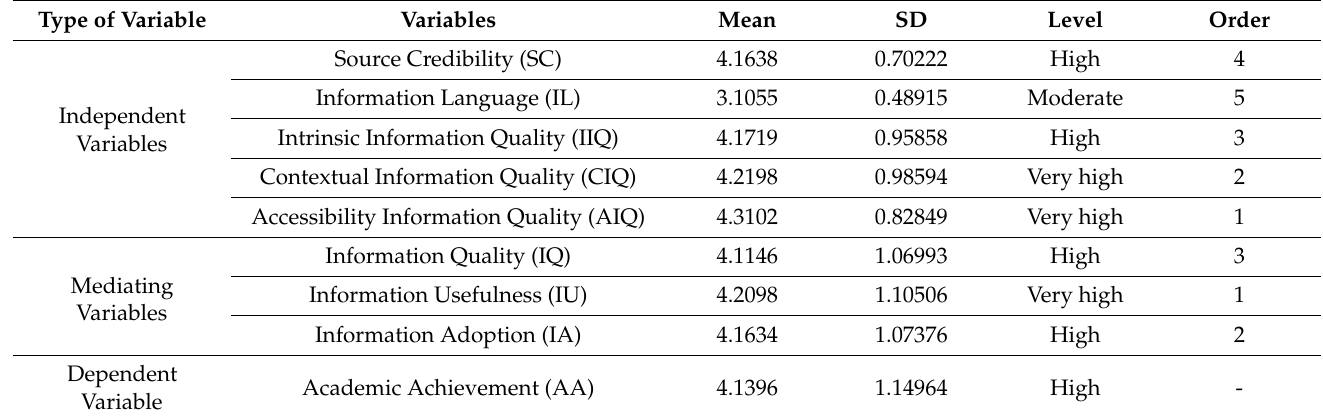
Table 3. Overall mean and standard deviation of the study’s